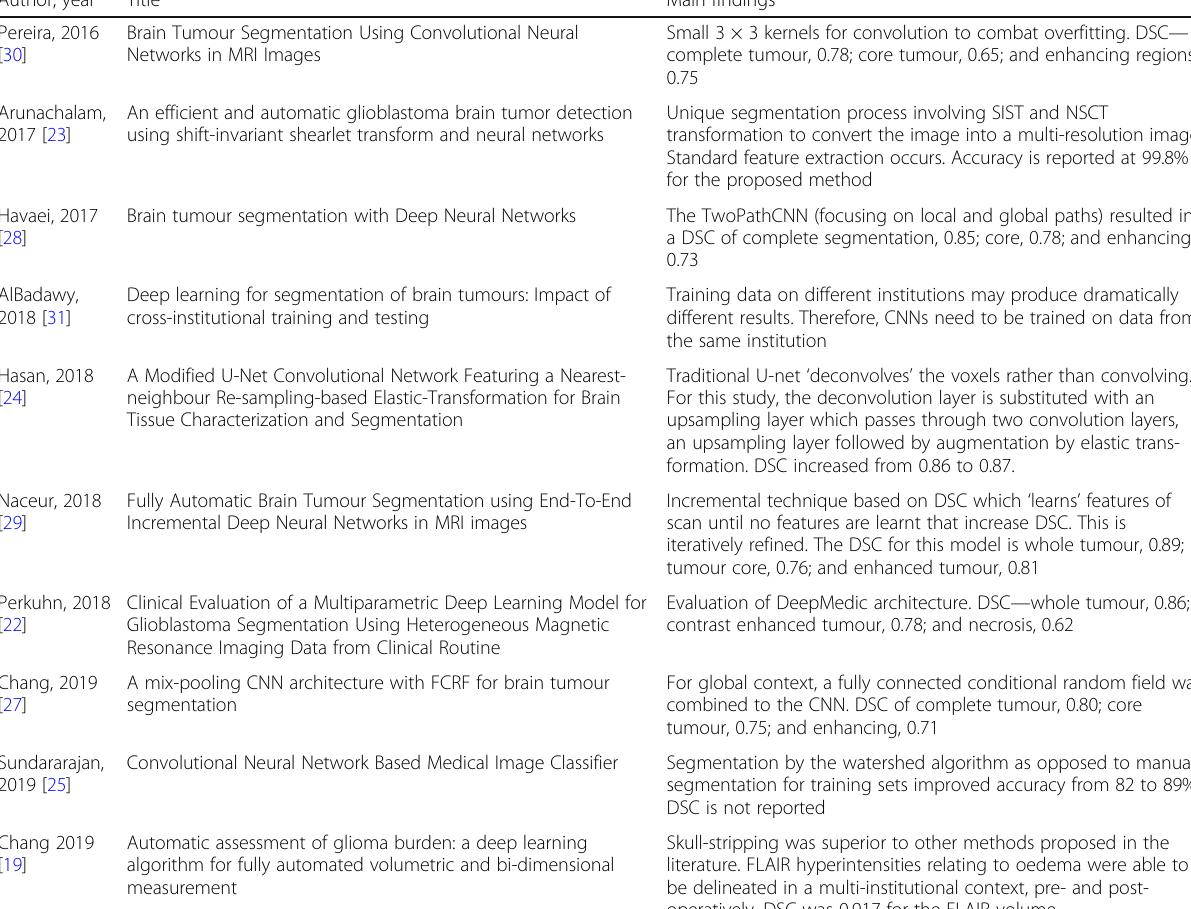
Table 1 CNN studies and main findings obtained from literature